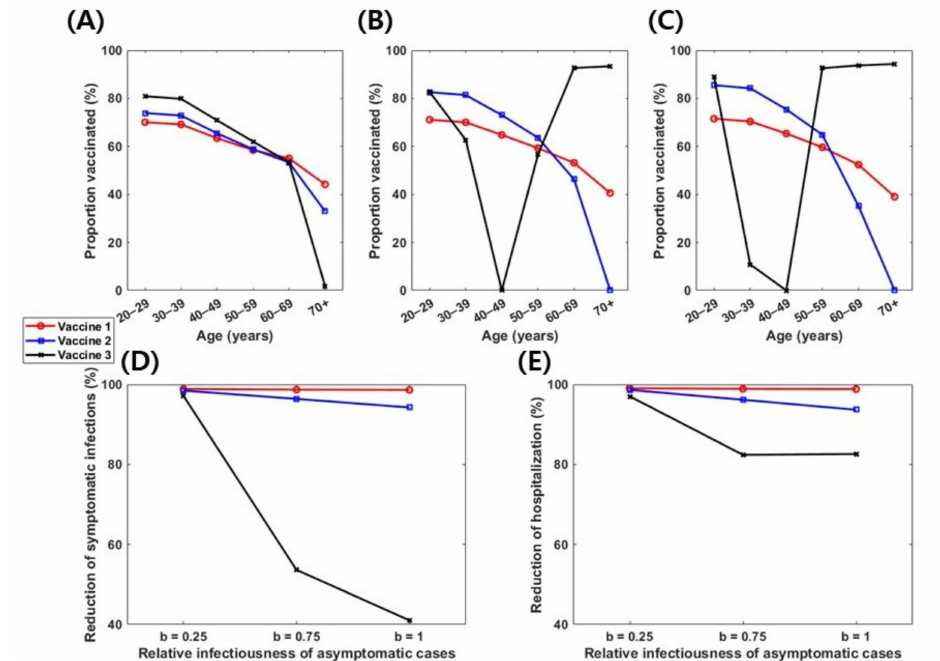
Figure 5. Effect of the relative infectiousness of asymptomatic infections on optimal vaccination strategies. ( A – C ) Age- specific optimal vaccination coverage levels with vaccines 1, 2, and 3, when b = 0.25 ( A ), 0.75 ( B ), and 1 ( C ). ( D ) Corre- sponding proportion of reduction in number of patients with symptomatic infections relative to non-vaccinated cases. ( E ) Corresponding proportion of reduction in hospitalizations relative to non-vaccination cases.